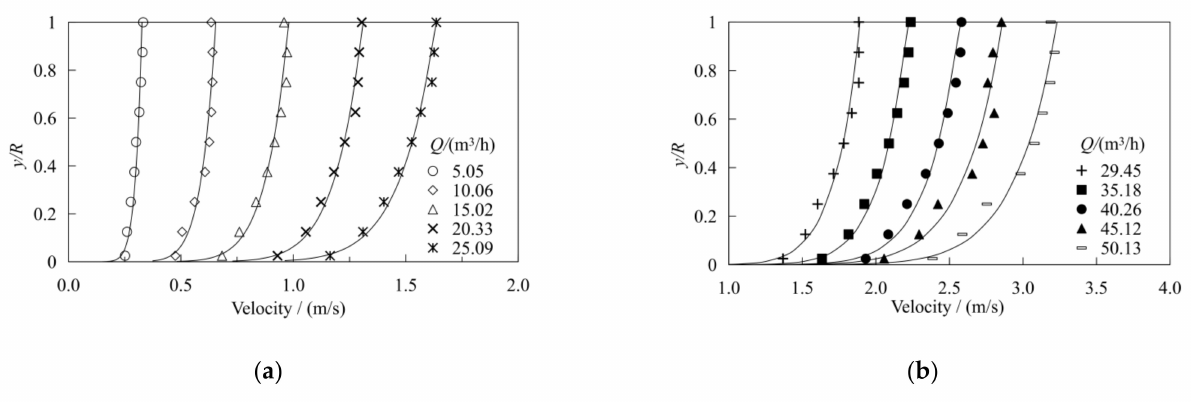
Figure 4. Observed clear water velocity distribution with different flow discharges: ( a ) Q = 5.05–25.09 m 3 /h; and ( b ) Q = 29.45–50.13 m 3 /h.